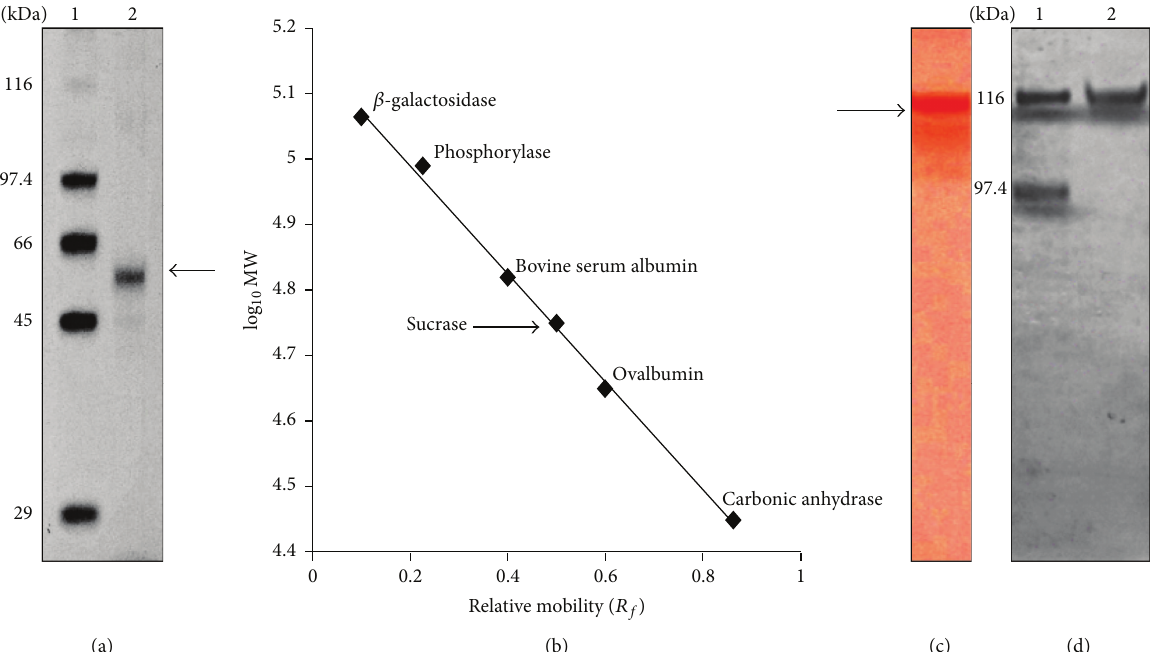
Figure 2: Gel electrophoretic analysis and activity staining of purified intracellular sucrase. (a) Electrophoresis (10% SDS-PAGE) was done in a discontinuous buffer system. Lane 1: molecular mass standards indicated on the left are as follows: galactosidase (116kDa), phosphorylase B (97.4kDa), bovine serum albumin (66 kDa), ovalbumin (45kDa), carbonic anhydrase (29kDa); lane 2 shows the purified intracellular sucrase protein band of nearly ∼ 56 kDa in size. (b) 10% SDS-PAGE standard curve plotted with logarithm of the molecular weight against relative mobility. The arrow indicates the log of molecular weight of intracellular sucrase subunit in 10% SDS-PAGE. (c) Substrate staining of purified intracellular sucrase in native gel; the arrow indicates the activity band in native gel. (d) Coomassie stained purified intracellular sucrase in native gel. Lane 1 represents the proteins galactosidase (116kDa) and phosphorylase B (97.4kDa) as molecular weight marker and lane 2 shows the native form of purified intracellular sucrase.